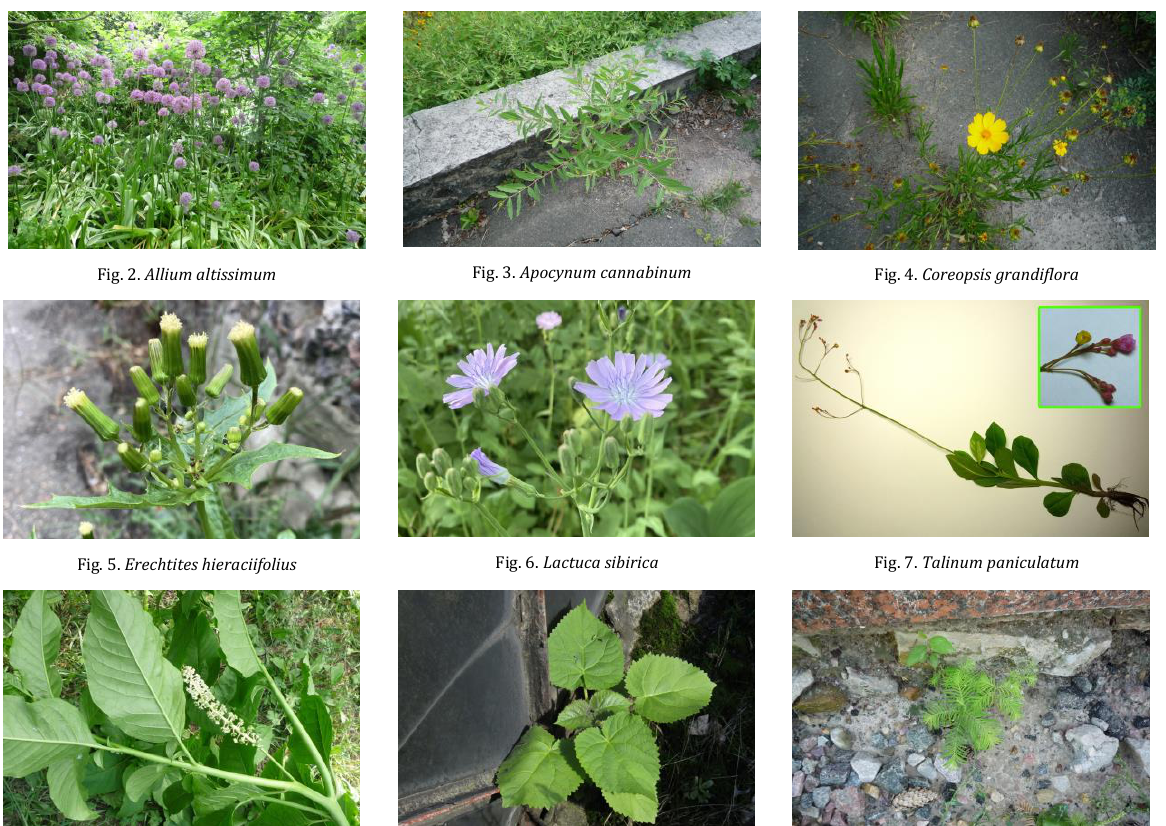
Fig. 5. Erechtites hieraciifolius Fig. 6. Lactuca sibirica Fig. 7. Talinum paniculatum